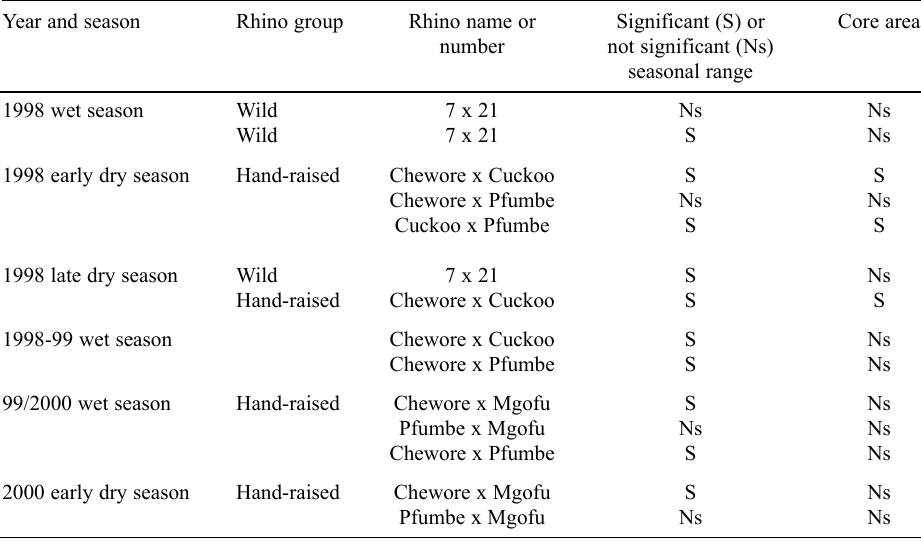
Chi-square tests on the differences in seasonal range and core area sizes within hand-raised and wild rhino